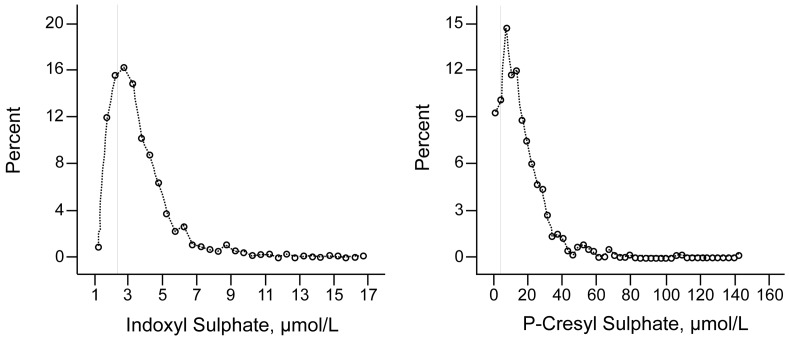
Distribution of indoxyl sulfate and p-cresyl sulfate.The vertical line is the limit of quantification.